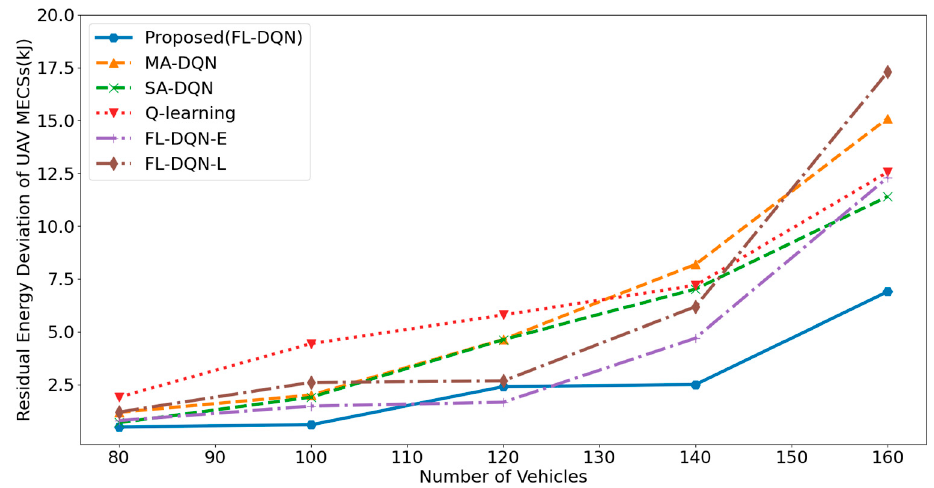
Figure 4. Residual energy deviation of UAV MECSs with varying number of vehicles.